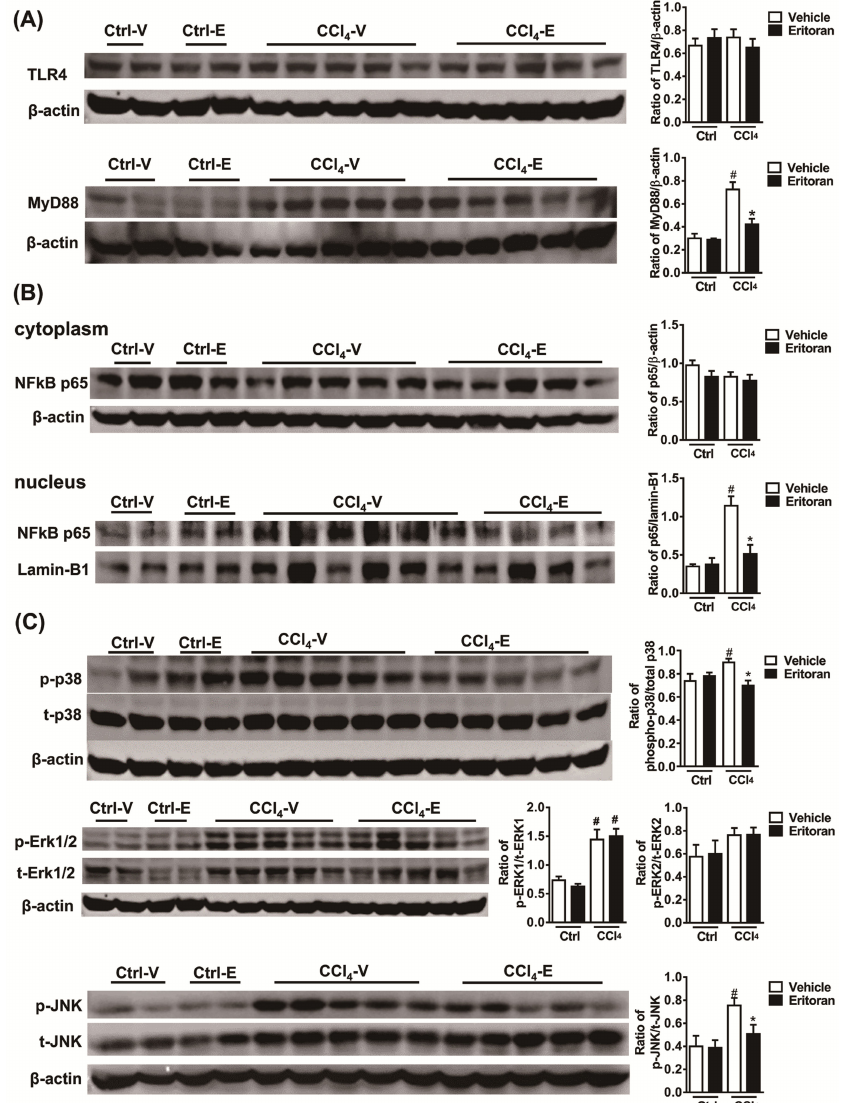
Scale bar = 100 µ m. Tissue sections from all the mice were stained and quantified (means ± SEM). ( C ) Hepatic transcript levels of α -smooth muscle actin ( Acta2 ), collagen 1 α 1 ( Col1a1 ), tissue inhibitor of metalloproteinase 1 ( Timp1 ) and matrix metalloproteinase 2 ( Mmp2 ). ( D ) Immunohistochemical staining for α -SMA of the liver sections and quantification of the positively stained areas (%). Scale bar = 100 µ m. Tissue sections from all the mice were stained and quantified (means ± SEM). ( E ) Western blotting of α -SMA and transforming growth factor- β 1 (TGF- β 1) in the livers. Ctrl-V/Ctrl- E: the mice that received corn oil (Ctrl) were treated with a vehicle (V) or eritoran (E); CCl 4 -V/CCl 4 -E: the CCl 4 -injured mice were treated with a vehicle (V) or eritoran (E); # p < 0.05 vs. Ctrl-V; * p < 0.05 vs. CCl 4 -V.